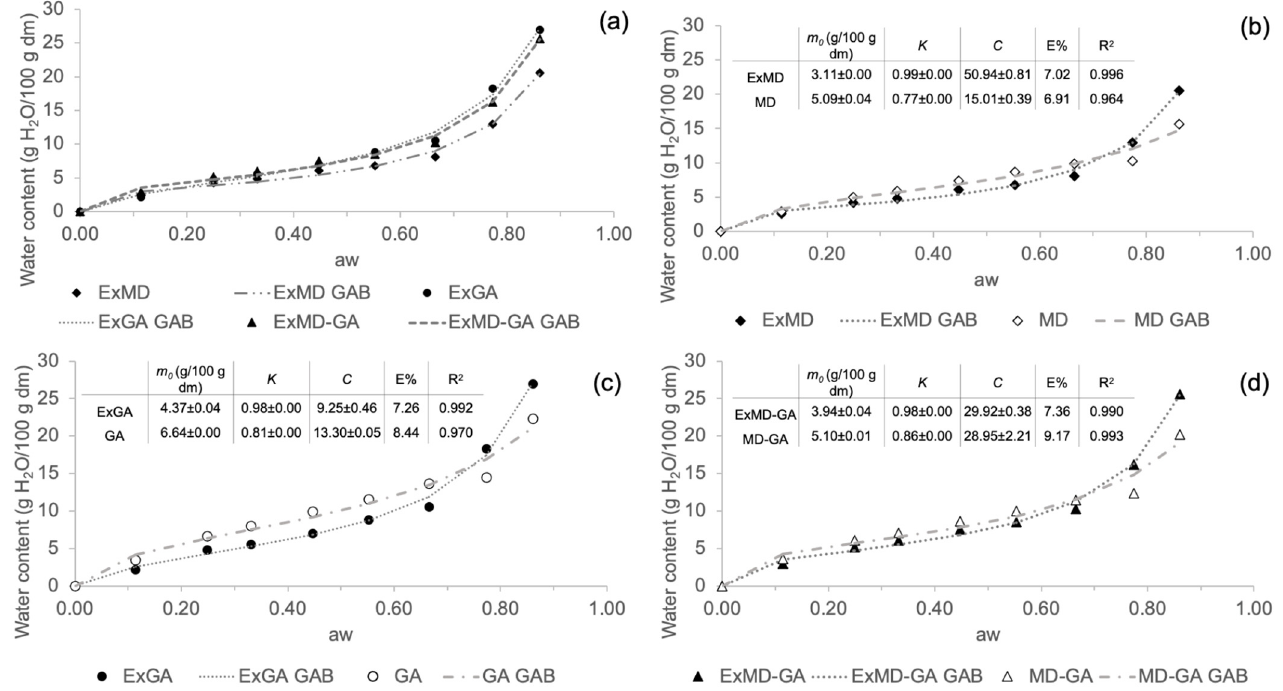
Figure 1. Sorption isotherms at 25 °C of the freeze-dried carriers (reference) and of the corresponding encapsulated hop extracts. ( a ) Comparison of the differently formulated reference freeze-dried powders without the extract (solid symbols); ( b ) microencapsulated hop extract made of maltodextrin and its reference; ( c ) microencapsulated hop extract made of Arabic gum and its reference; ( d ) microencapsulated hop extract made of maltodextrin and Arabic gum mix (ratio 1:1; w / w ) and its reference. Data have been fitted with the GAB model (dashed and dotted lines), and fitting parameters are reported in inserts.